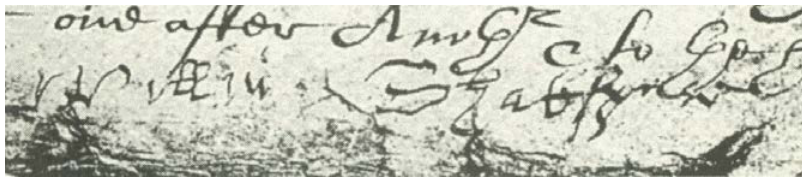
Fig. 5 – Signature n. 5 on page 2 of Shakespeare’s Last Will (1616)